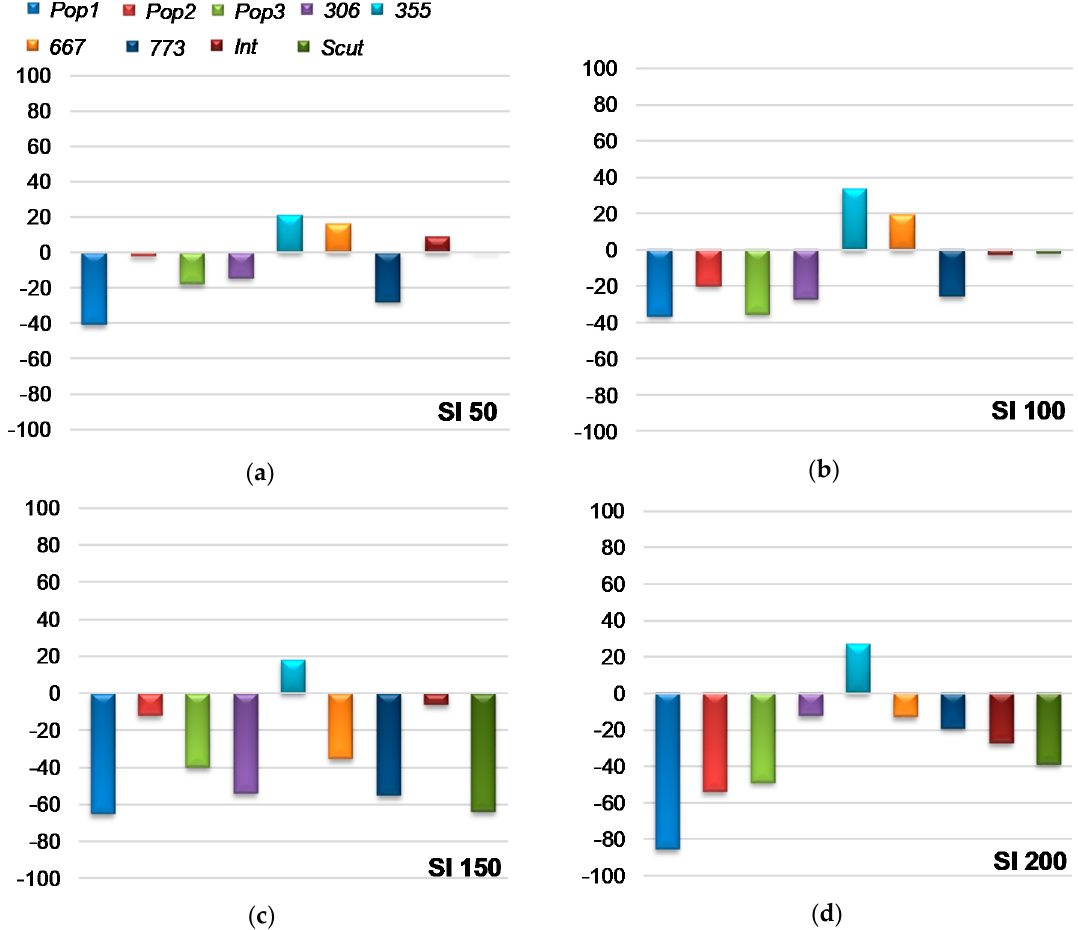
Figure 1. Effect of salt stress (0, 50, 100, 150, 200 mM NaCl) on salt sensitivity index (SI) for final germination percentage (FGP), noted SI ( FGP ) , of M. ciliaris populations ( Pop1, Pop2, Pop3, 306, 355, 667, 773 ) compared to one population of M. intertexta ( M. int ), and one population of M. scutellata ( M. scut ). The values are the average of 10 seeds replicated 5 times.